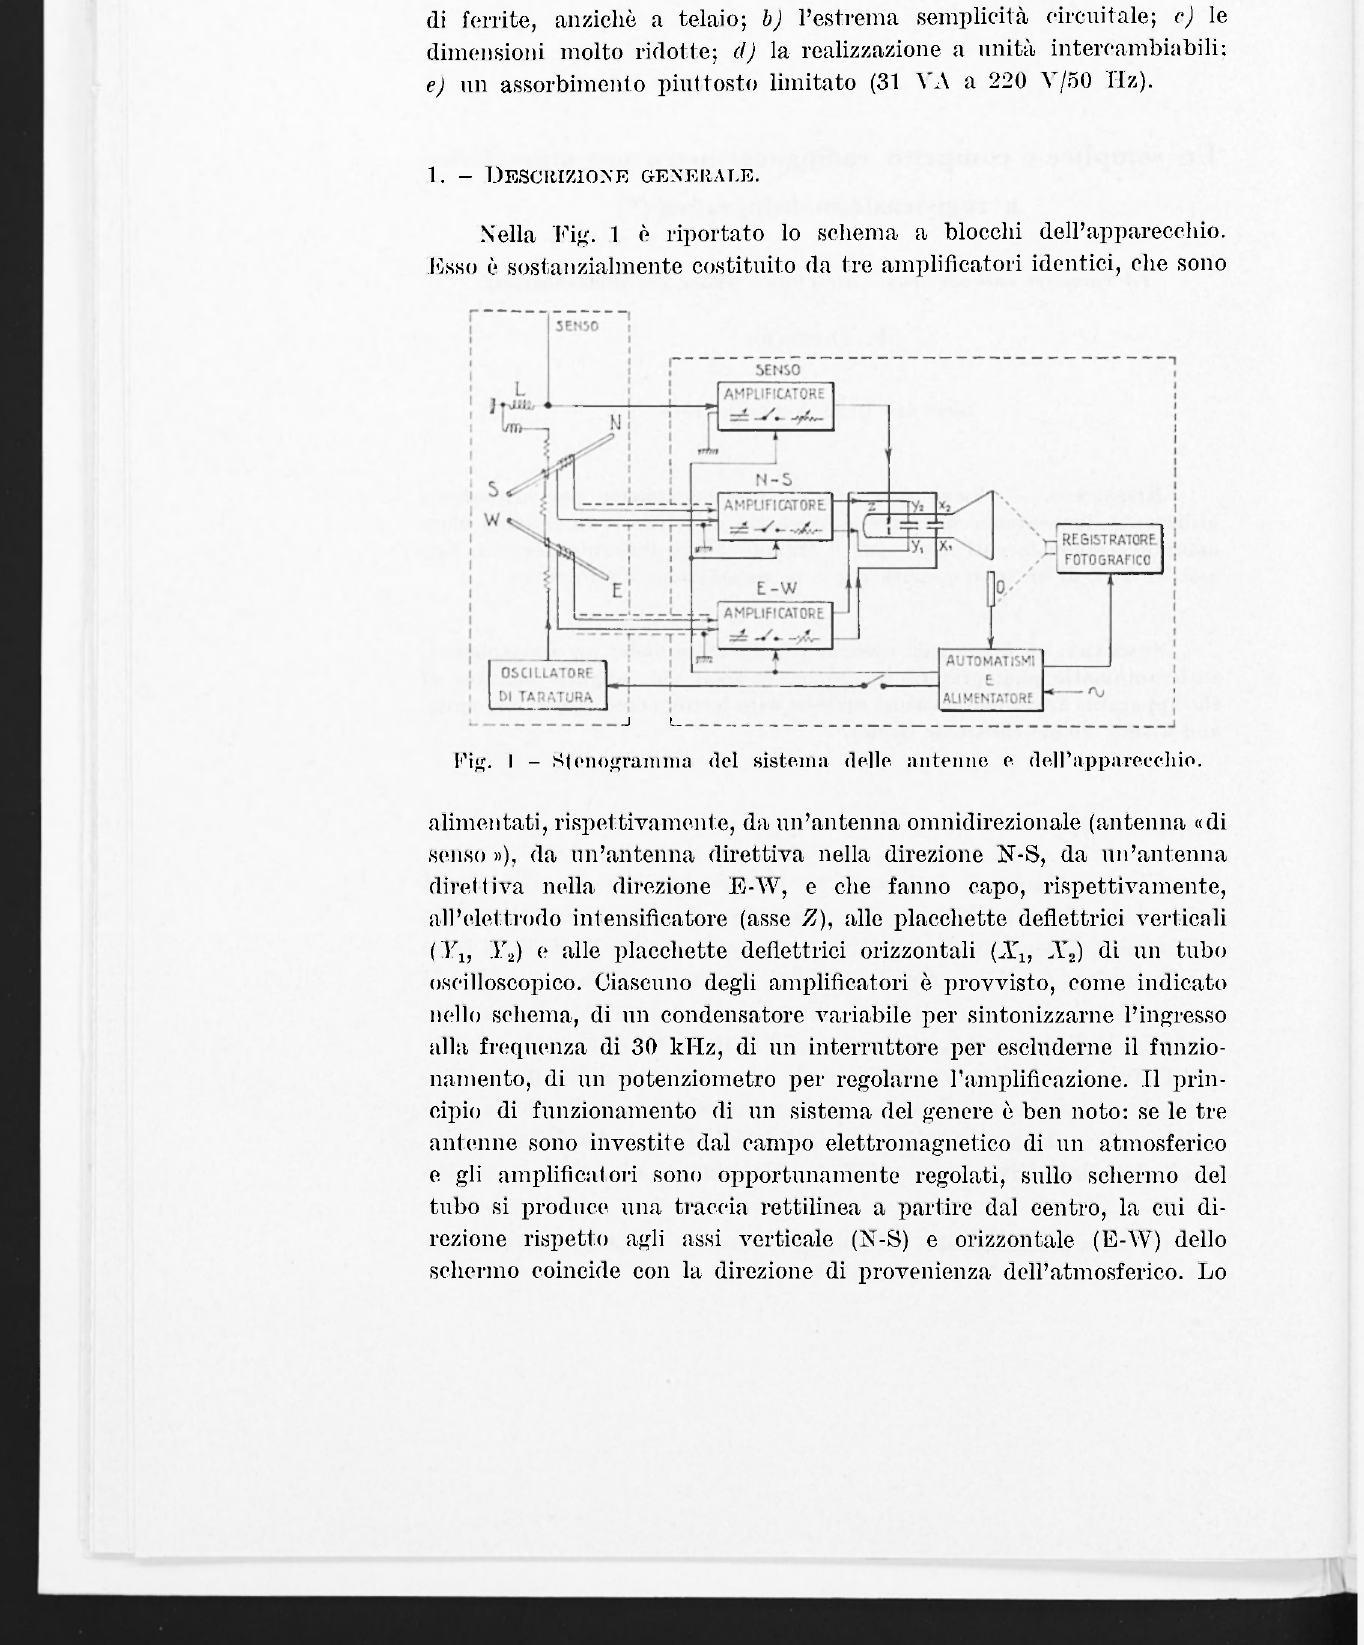
Nella Fig. 1 è riportato lo schema a blocchi dell'apparecchio.